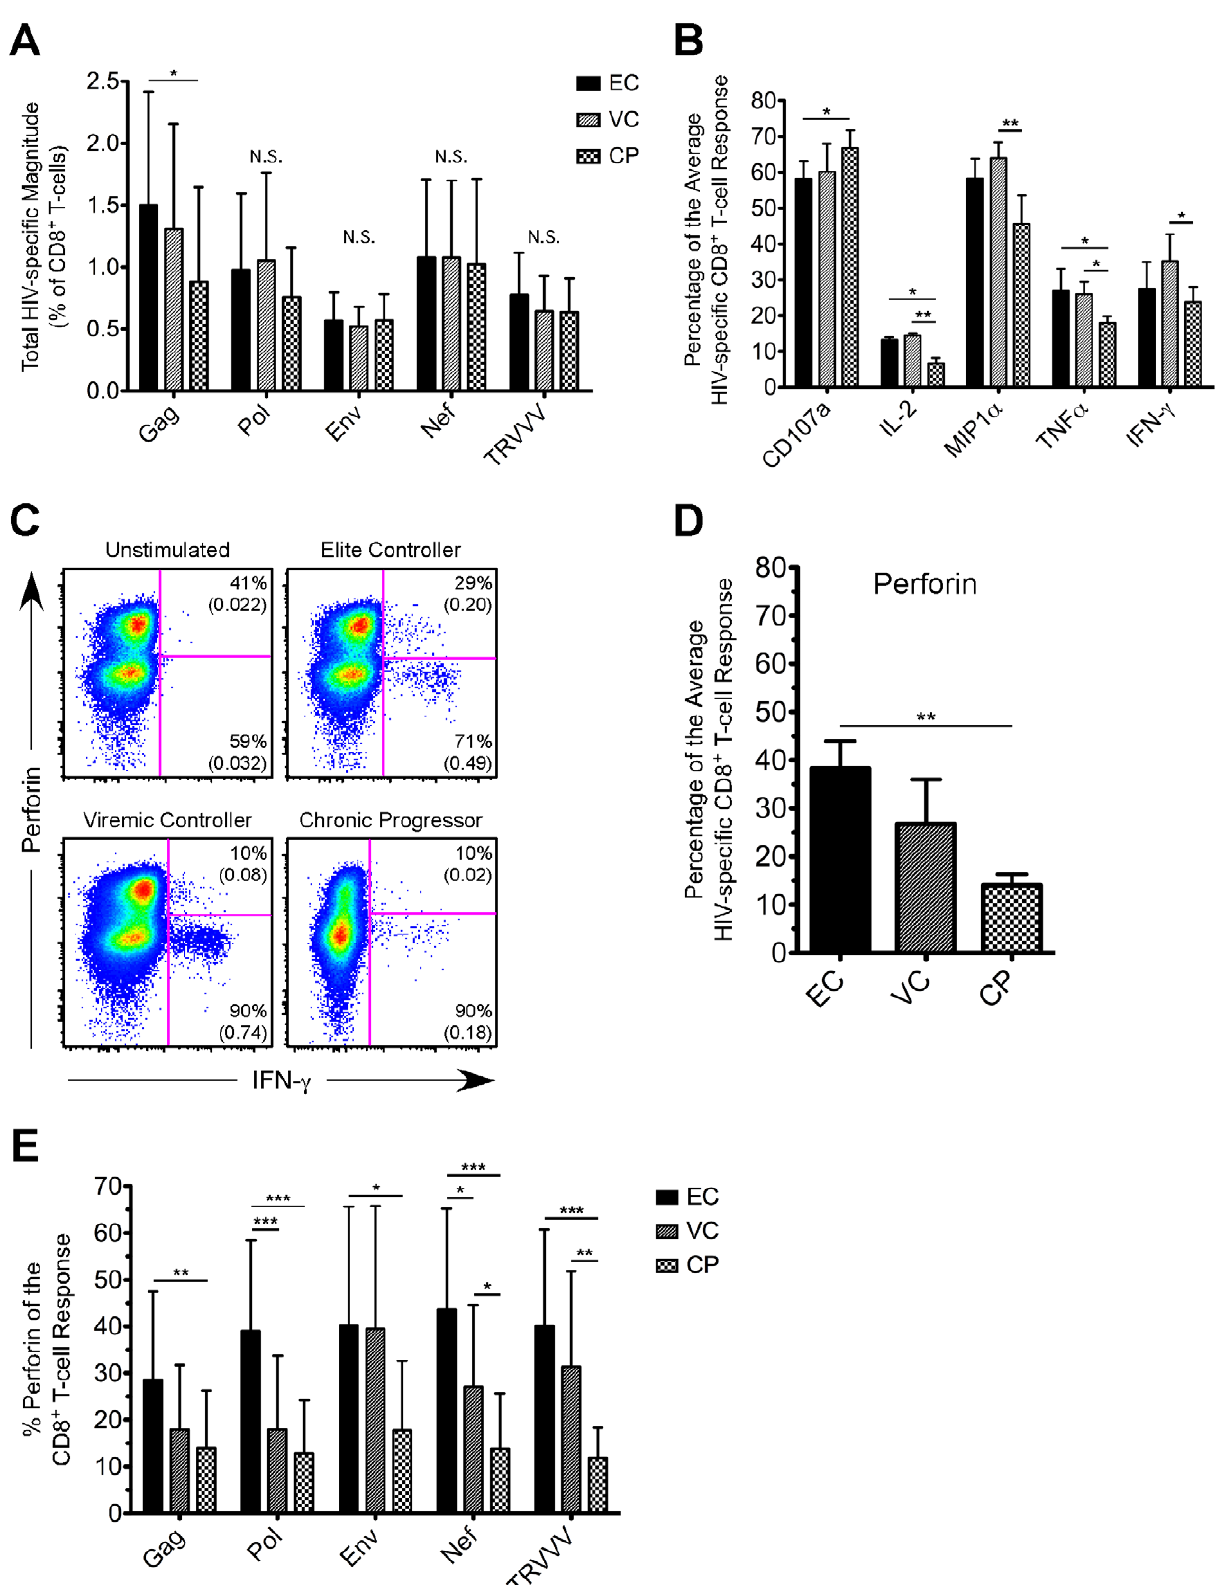
Figure 1. HIV-specific CD8 + T-cells in EC demonstrate an enhanced ability to express perforin compared to CP. (A) The CD8 + T-cell response magnitude to all HIV peptide pools was calculated for EC, VC, and CP and plotted as percent of CD8 + T-cells (excluding naı¨ve cells). The total magnitude was calculated by summing across all functional combinations. (A) The proportion of the average HIV-specific CD8 + T-cell response